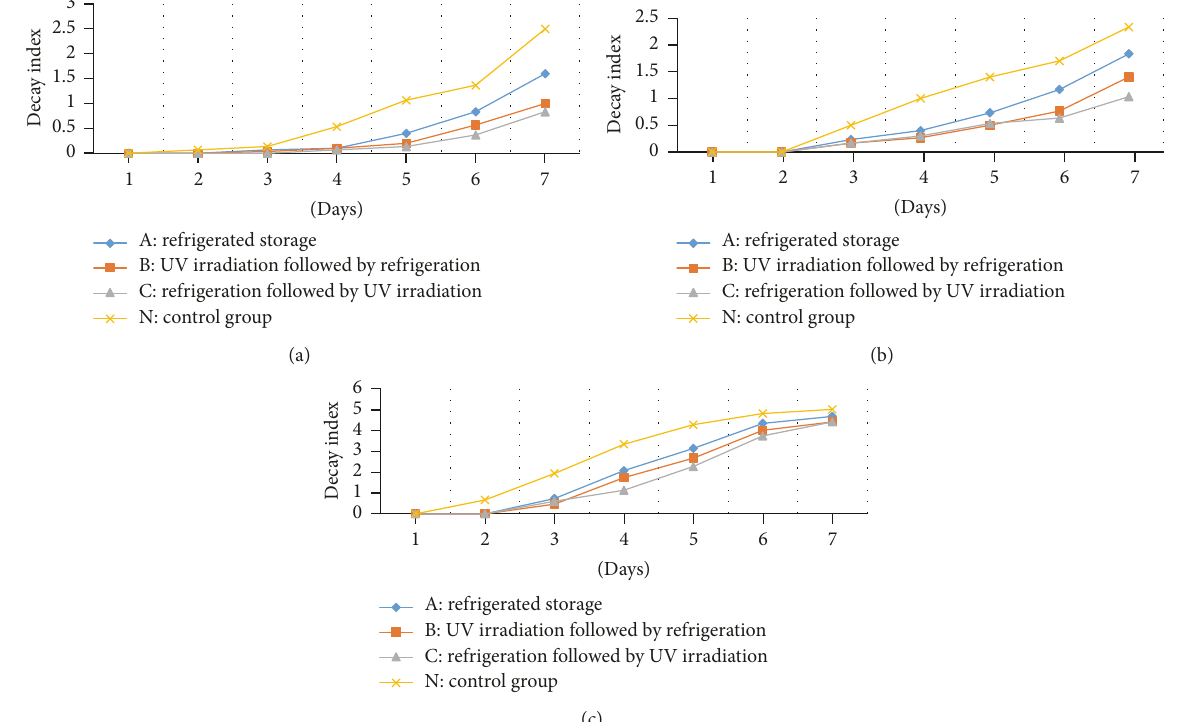
Figure 1: Decay proliferation of litchis (a), longans (b), and rambutans (c) during first week after treatments.